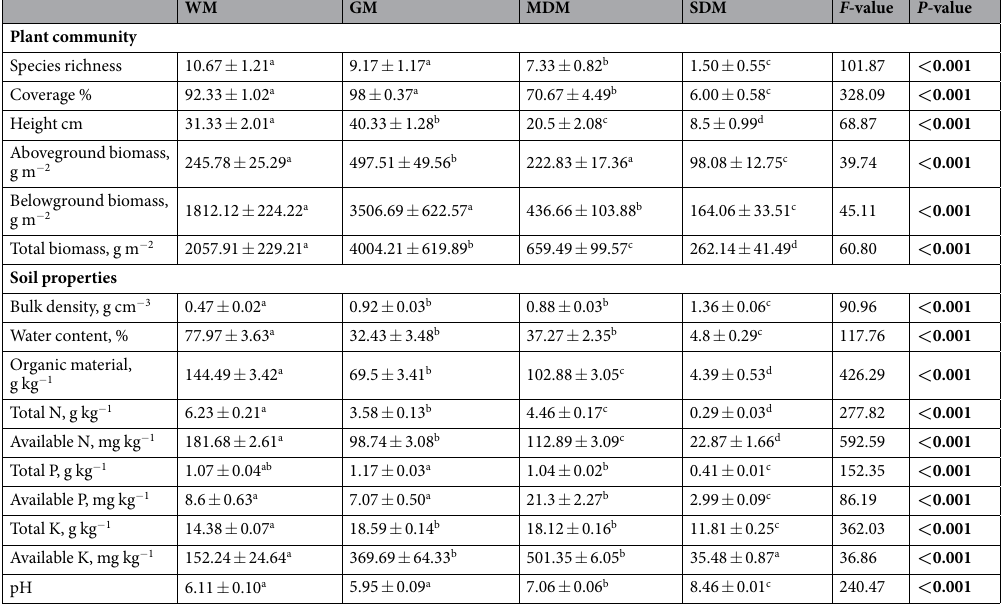
Table 2. Mean values (mean ± S.E.) and significance tests of the environmental characteristics at different degradation phases of Zoigê Wetland (n = 6). Statistically significant ( P < 0.05) results from one-way ANOVA followed by Tukey’s multiple comparison test are shown in bold. Different superscript lowercase letters in the same row indicate significant differences at the P < 0.05